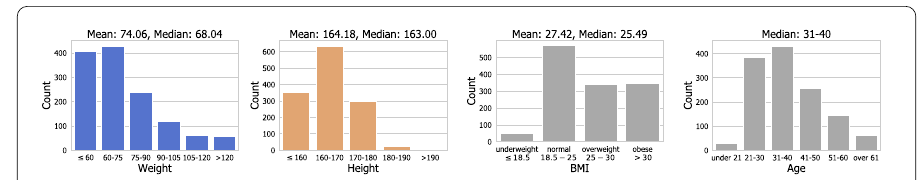
Figure 5 Women crowd workers (N = 1313, 54.1% of all